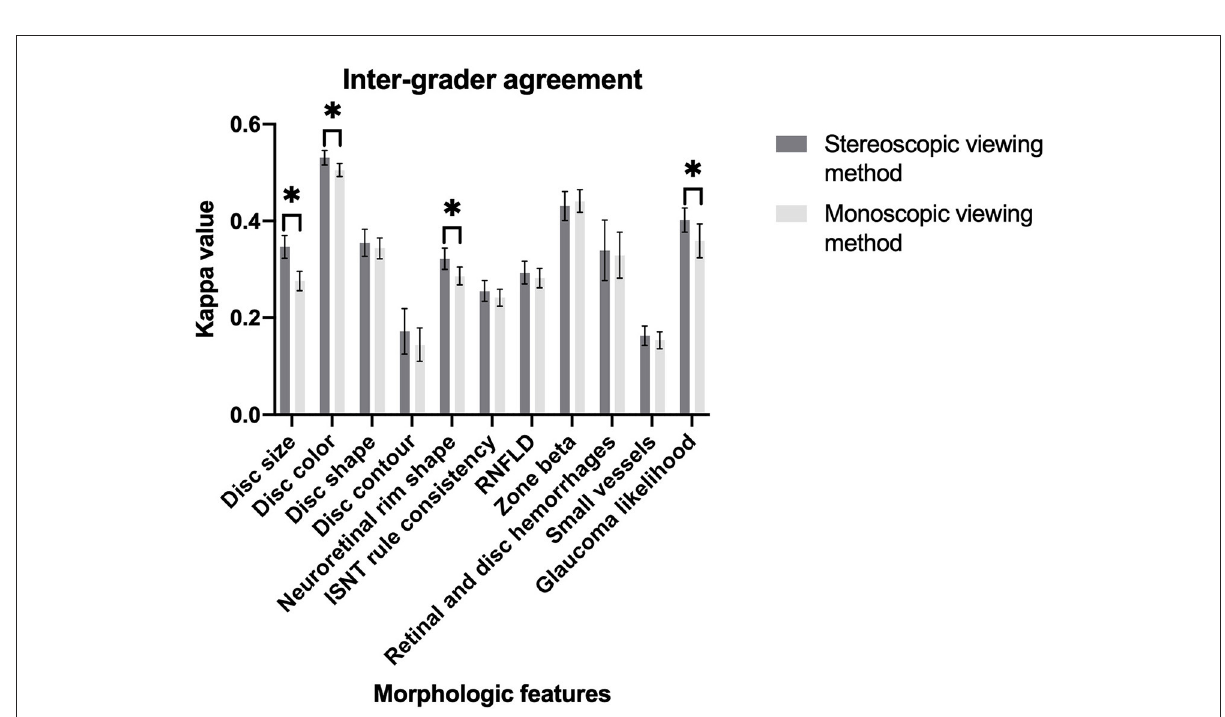
FIGURE3 Magnitude of inter-grader agreement of different viewing methods for morphologic features of optic disc and glaucoma likelihood (* P <